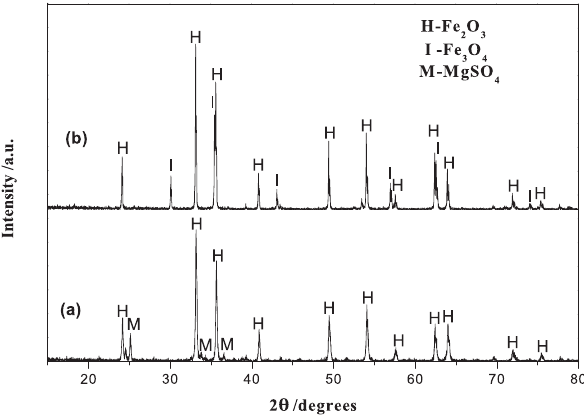
Fig. 6: XRD profiles of the products at 850°C, (a) conventional calcinations and (b) microwave calcinations.